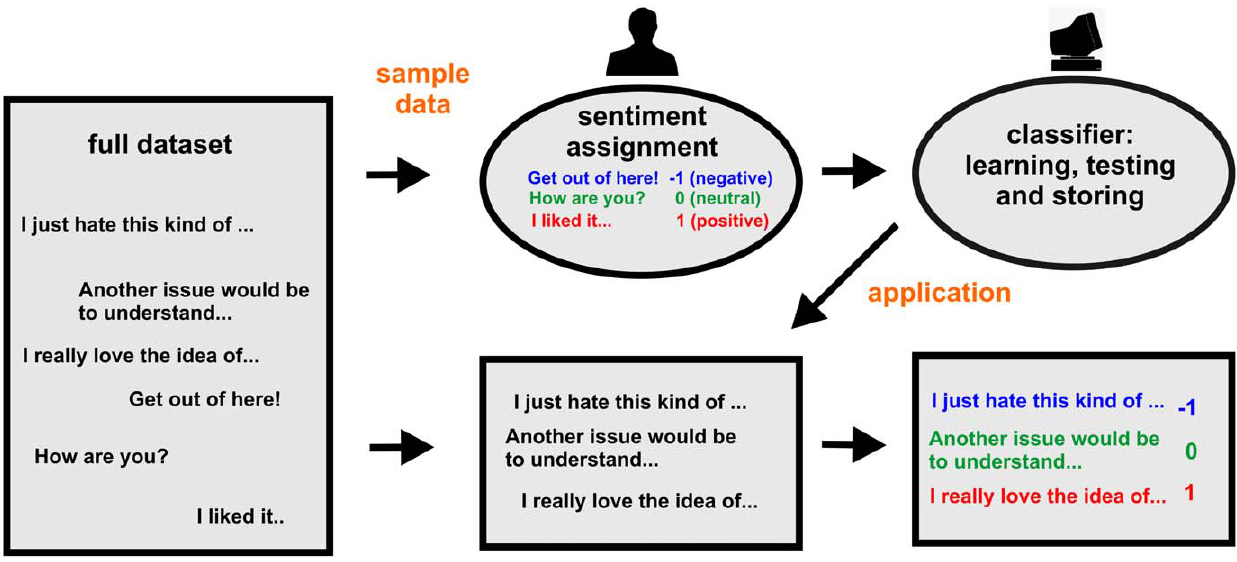
Figure 1. Schematic plot of the process of document classification. A sample from the set of documents is passed to human experts who read the content and manually classify it. The algorithm extracts the characteristics of each class by analyzing the provided documents, i.e., ‘‘learns by example’’, and stores this knowledge. As result each document is classified with the emotional value –1, 0 or + 1 describing its emotional valence.